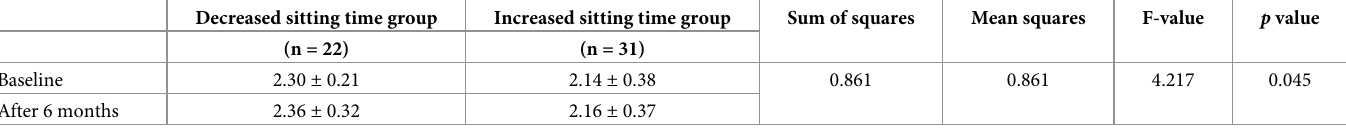
Table 2. Two-way ANOVA measurements comparing log HF during sleep between the decreased sitting time and increased sitting time groups at baseline and after 6 months. Decreased sitting time